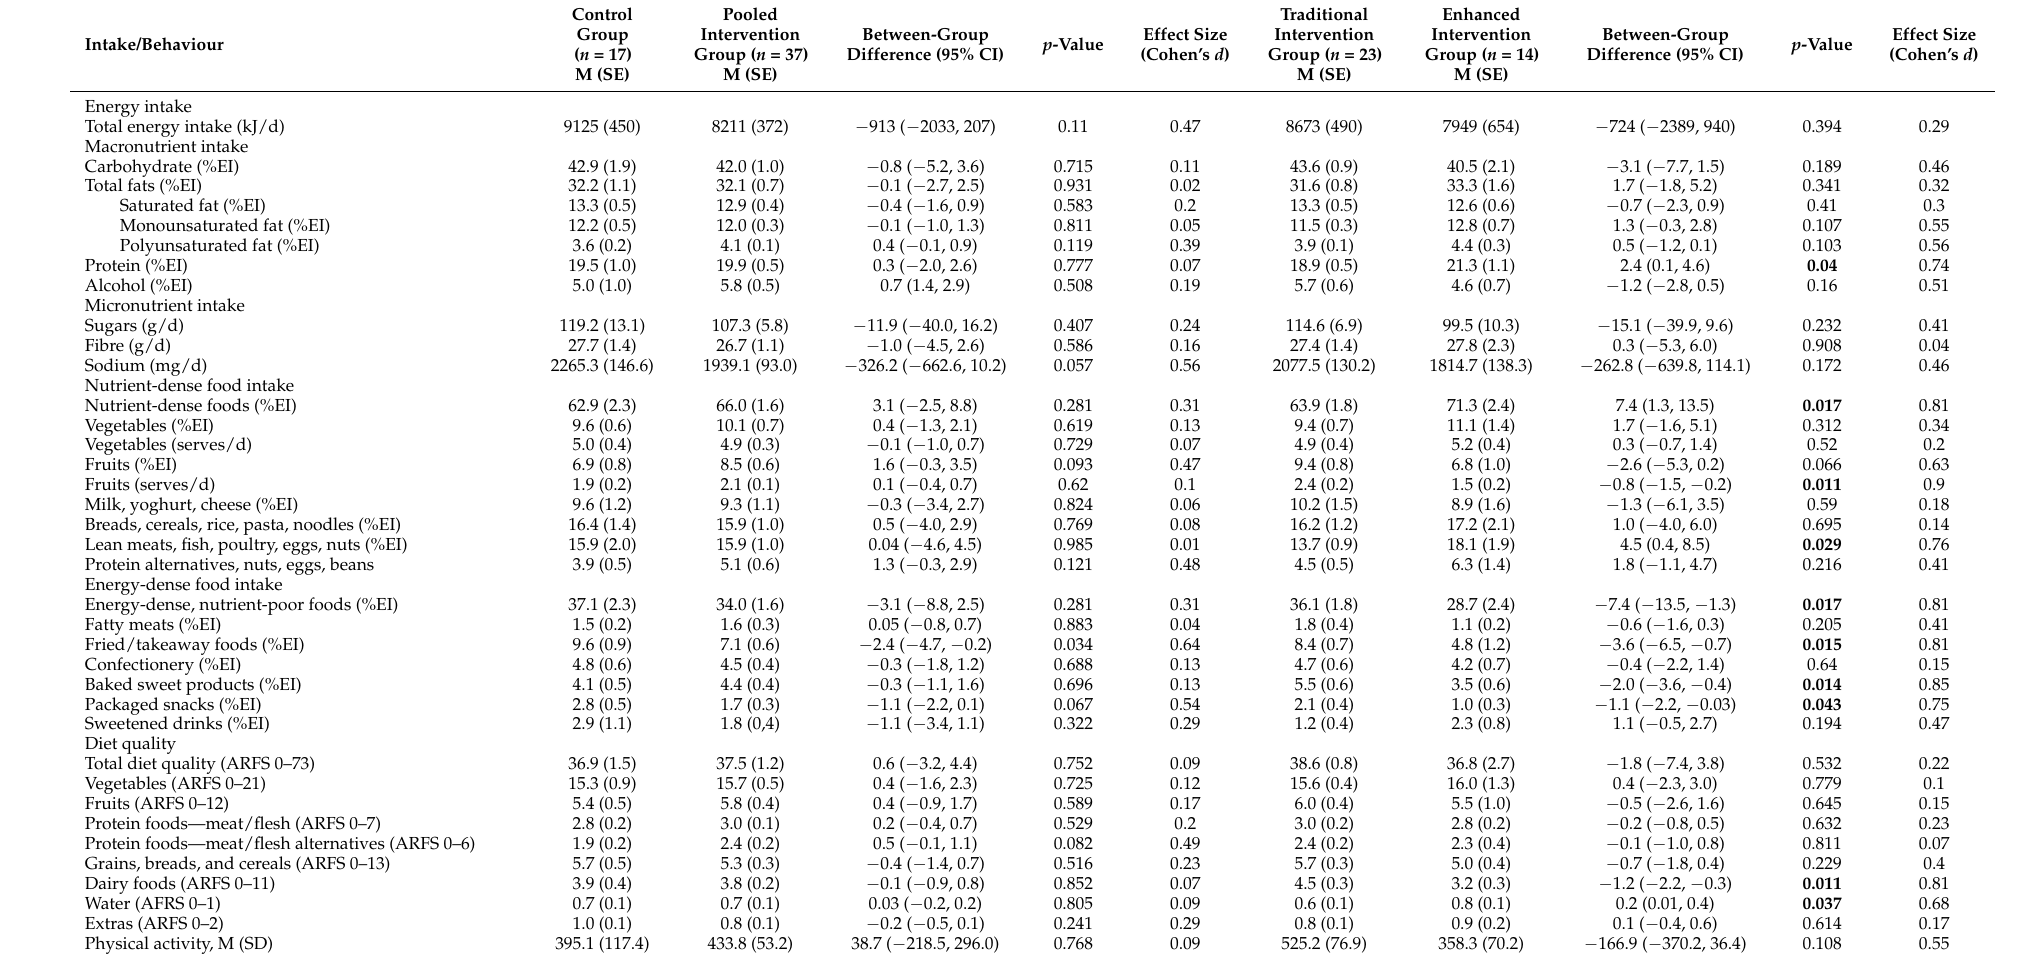
Table 3. Between-group differences in dietary intake, physical activity and sleep health at 12 months ( n =